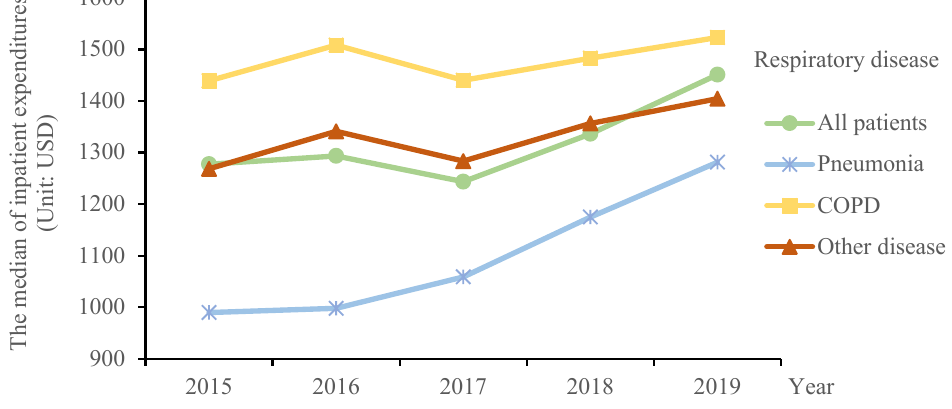
Figure 1. Trends in inpatient expenditure for respiratory diseases for 2015–2019.